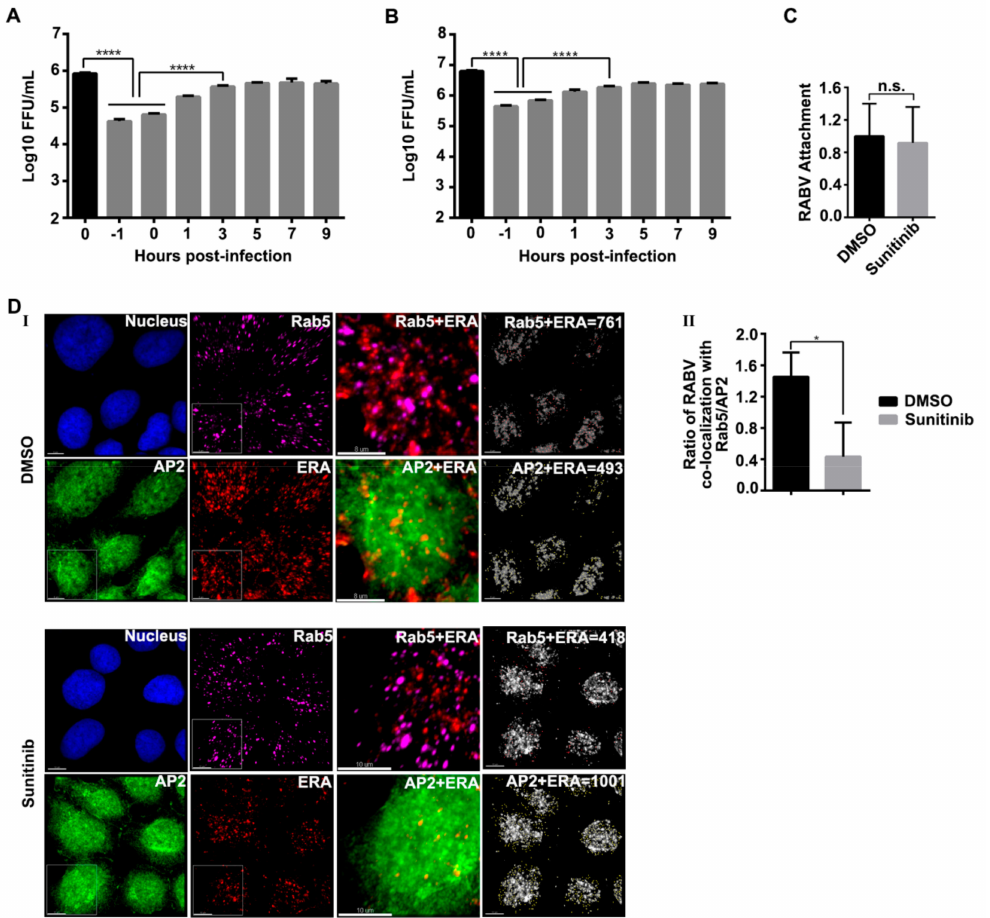
Figure 5. AAK1 functions at the early stage of RABV infection. HEK293 cells ( A ) and SK cells ( B ) were treated with sunitinib (3 µ M) at the indicated time points before or after ERA-mCherry infection. Viral titers in the supernatant were determined at 24 h post-infection. A one-way ANOVA was used for the statistical analysis. ****, p < 0.0001. ( C ) HEK-293 cells were treated with sunitinib (3 µ M) or DMSO for 1 h at 37 ◦ C, and then incubated with ERA-mCherry at an MOI of 2 for 2 h at 4 ◦ C. After removing unbound viruses by washing, total cellular RNA was extracted and subjected to qPCR to quantify cell-bound RABV RNA. A t-test was used for the statistical analysis. n.s., not significant. ( D ) Representative images showing tyramide signal amplification immunofluorescence staining of ERA-N-mCherry (red), AP2 (green), and Rab5 (purple) in sunitinib-treated or DMSO-treated cells ( I ). Co-localization of RABV with Rab5 or AP2 was observed and quantified in 15 to 20 randomly chosen cells from each sample. Statistical results represent the ratio of RABV:Rab5 co-localization normalized to RABV: AP2 co-localization ( II ). A t-test was used for the statistical analysis. *, p < 0.05. Bars, 8 or 10 µ